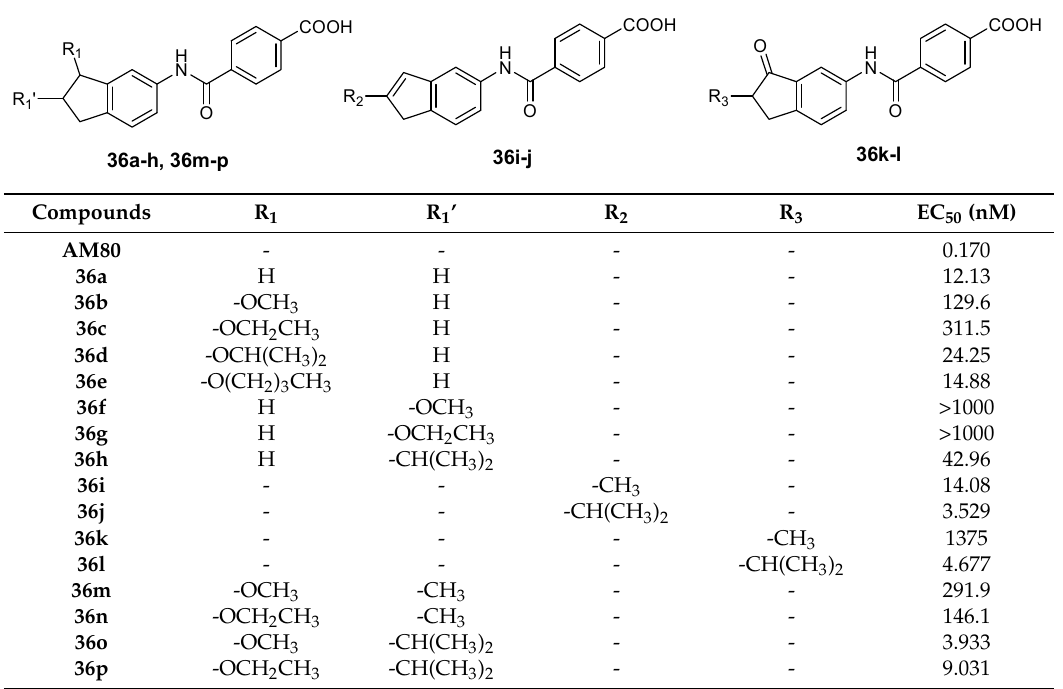
Table 1. RAR α binding affinity of compounds 36a – 36p .